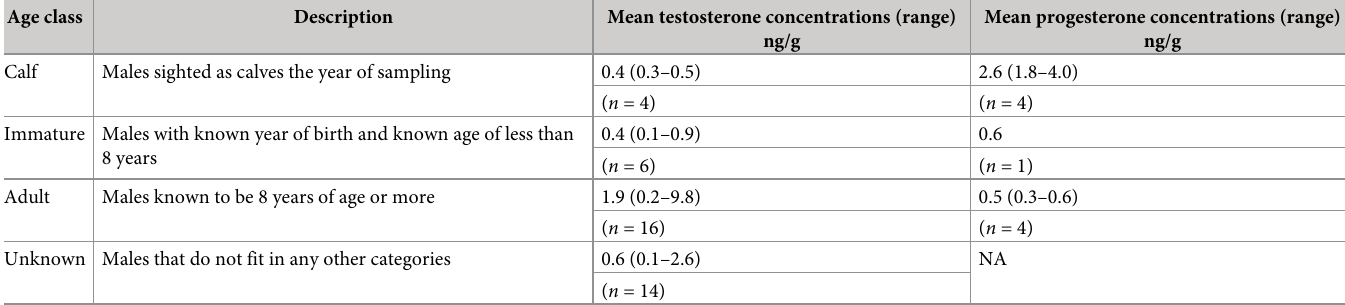
Table 1. Mean (range) of progesterone and testosterone concentrations in male gray whales. Divided by age class.